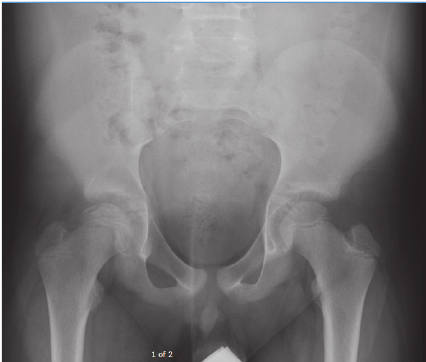
Figure1:APpelvisX-rayshowingavascularchangesofsubchondral cystic lucency without evidence of femoral head collapse.